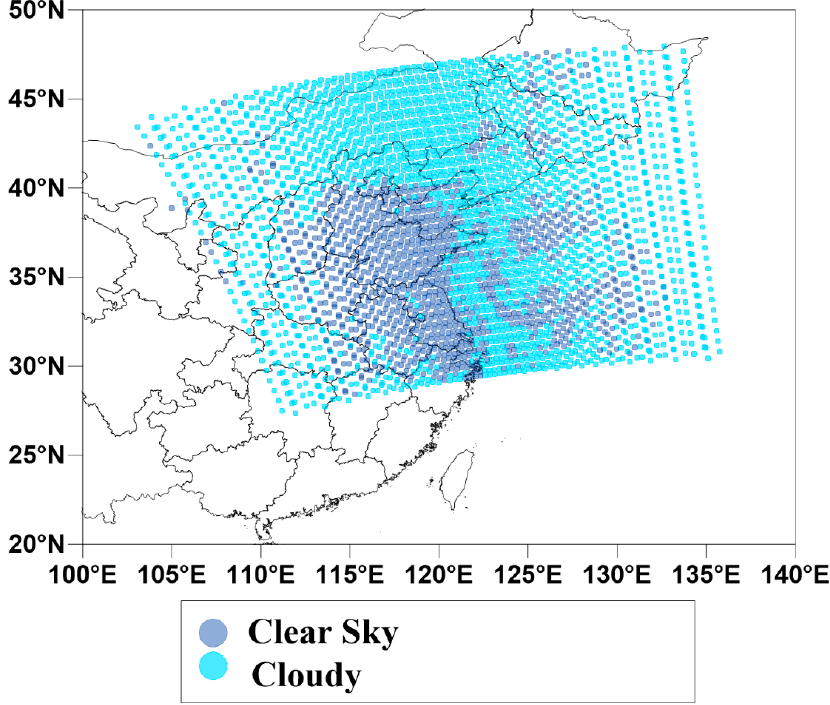
Figure 8. Cloud detection results for 12December 2018.